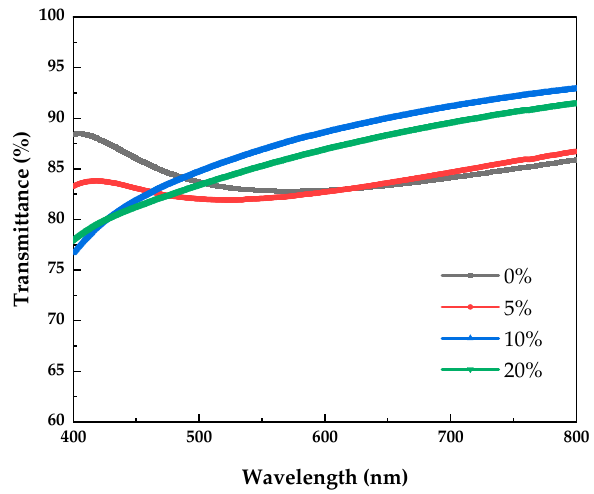
Figure 4. Transmission spectra of PrIZO thin films prepared under various oxygen partial pressures. Table 1. Optical properties of praseodymium-doped indium-zinc-oxide (PrIZO) thin films with different oxygen partial pressures.